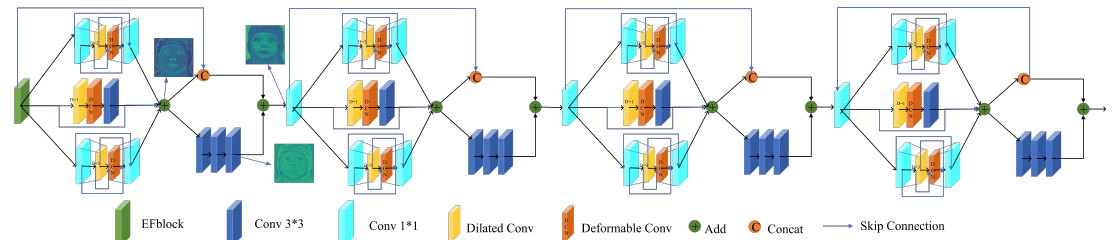
Figure 3. An overview of HMblock. HMblock includes the local multi-scale feature extraction module RF and the global residual connection used to extract the global multi-scale features, which together constitute the hybrid multi-scale